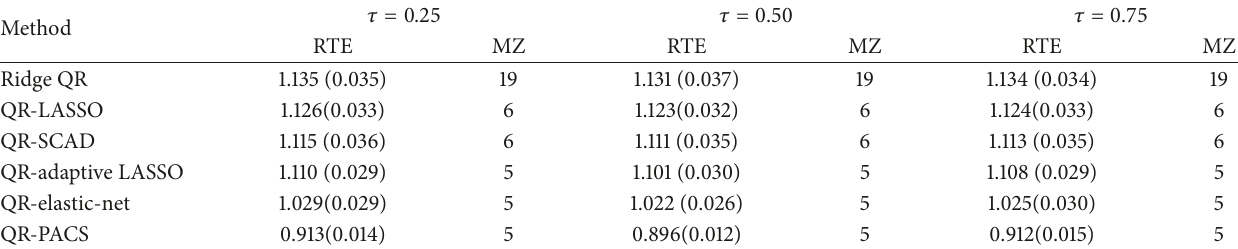
Table 6: The test error and the effective model size values for the methods under consideration based on the NCAA sport data.